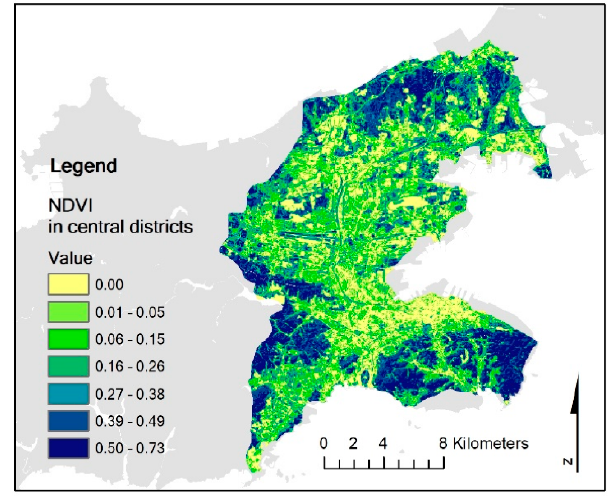
Figure 4. The NDVI in central districts.